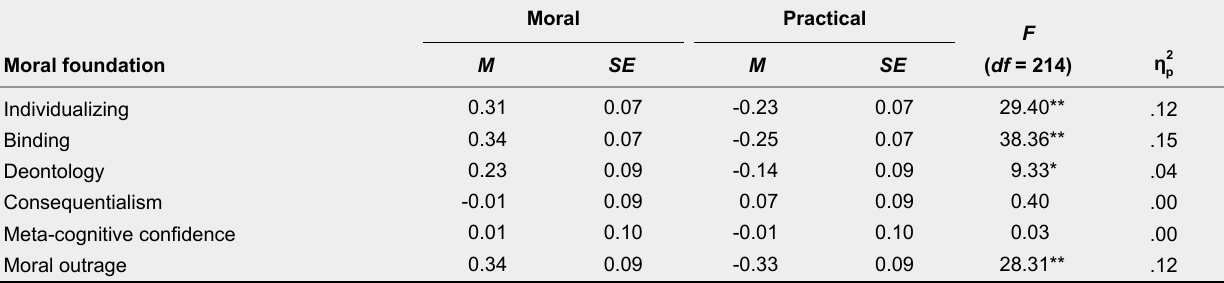
Means and SEs for All Dictionary Scores as a Function of Condition (Moral Versus Practical), Controlling for Initial Stance and Political Orientation in Study 2